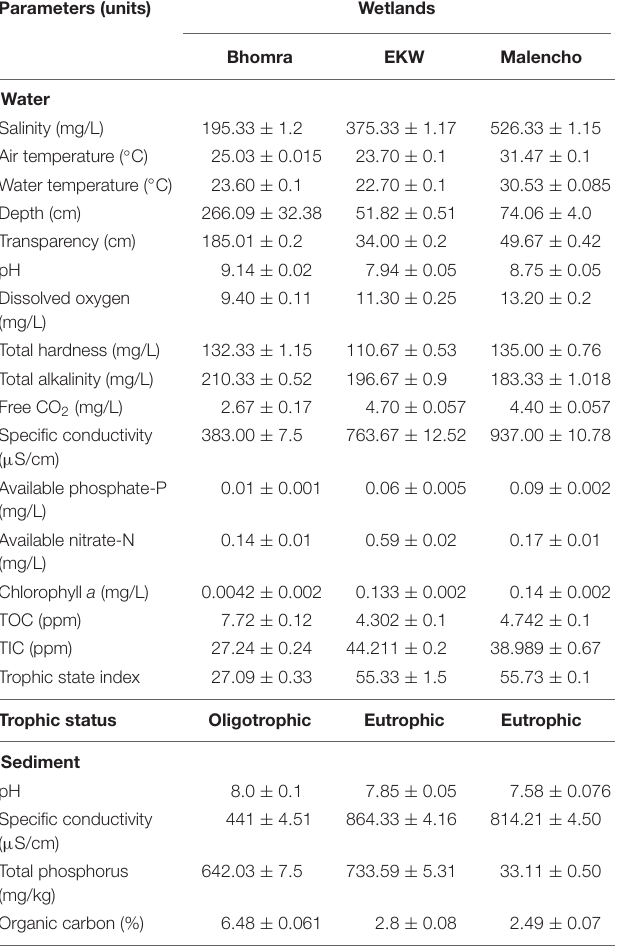
TABLE 1 | Physico-chemical parameters (mean ± SD) of water and sediment samples in Bhomra (freshwater), EKW (sewage-fed), and Malencho (brackish-water)